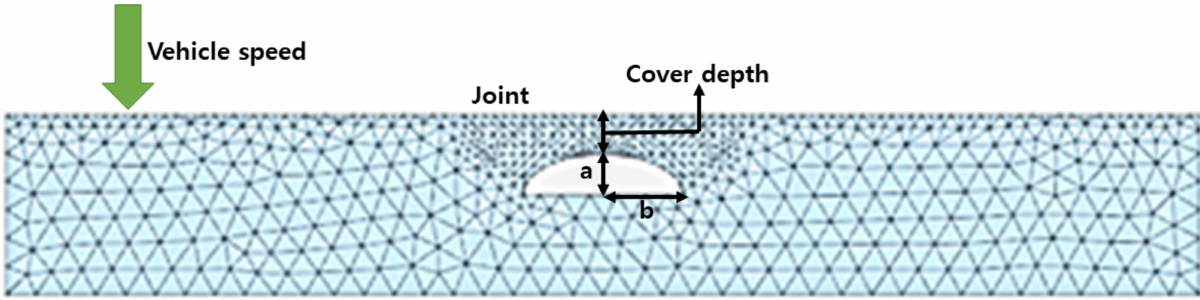
Figure 2. Lava tube geometry of finite element